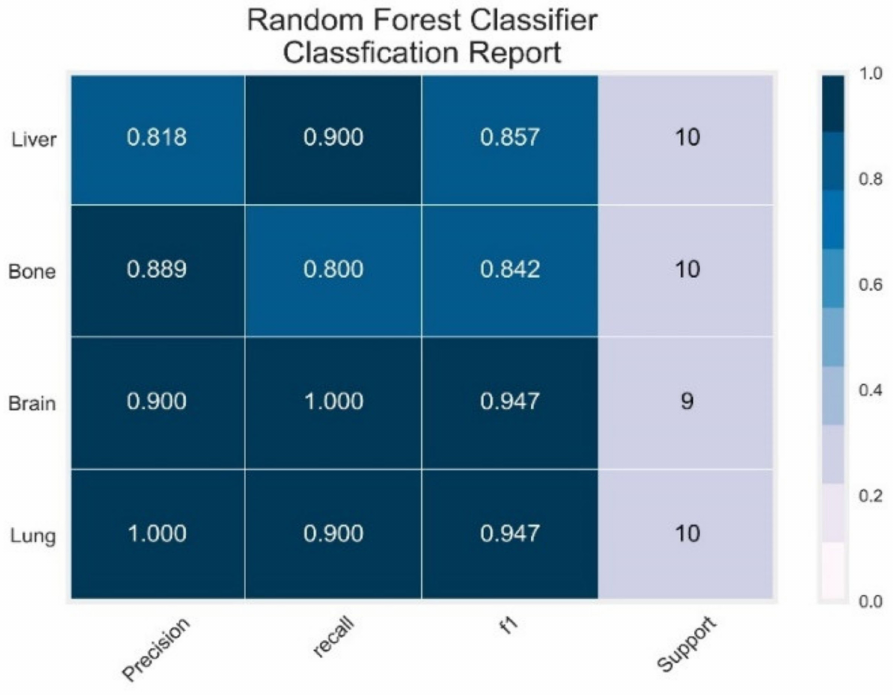
Figure 18. Classification Report (Random Forest Classifier). The precision-recall curve for the RF classifier is shown below in Figure